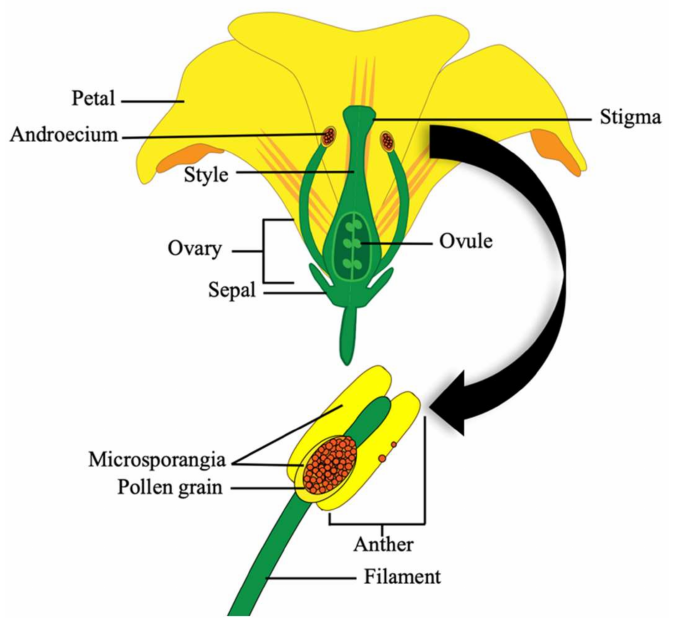
Figure 2. A stylised diagram of the tomato floral anatomy. This general morphology is consistent across angiosperms. The diagram illustrates the male sexual organs (androecium) that consists of the anther containing pollen grains encased in a sac-like structure called the microsporangia. The poricidal anther is not freely accessible and legitimate access is restricted to bees capable of vibrating the anther. Mechanical vibrations disrupt trichomes binding the poricidal anthers to assist in the release of pollen. The anther is attached to the filament that protrudes from below the female gynoecium. The gynoecium consists of the ovary, style and stigma to which the pollen grains